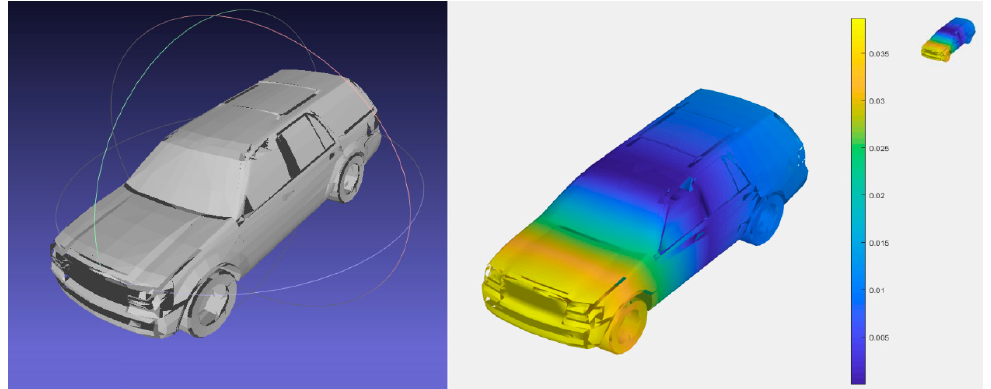
Figure 7. The original 3D car (left), the 3D color model using WKS value (middle) and the 2D projection 32 by 32 by 3 (right).